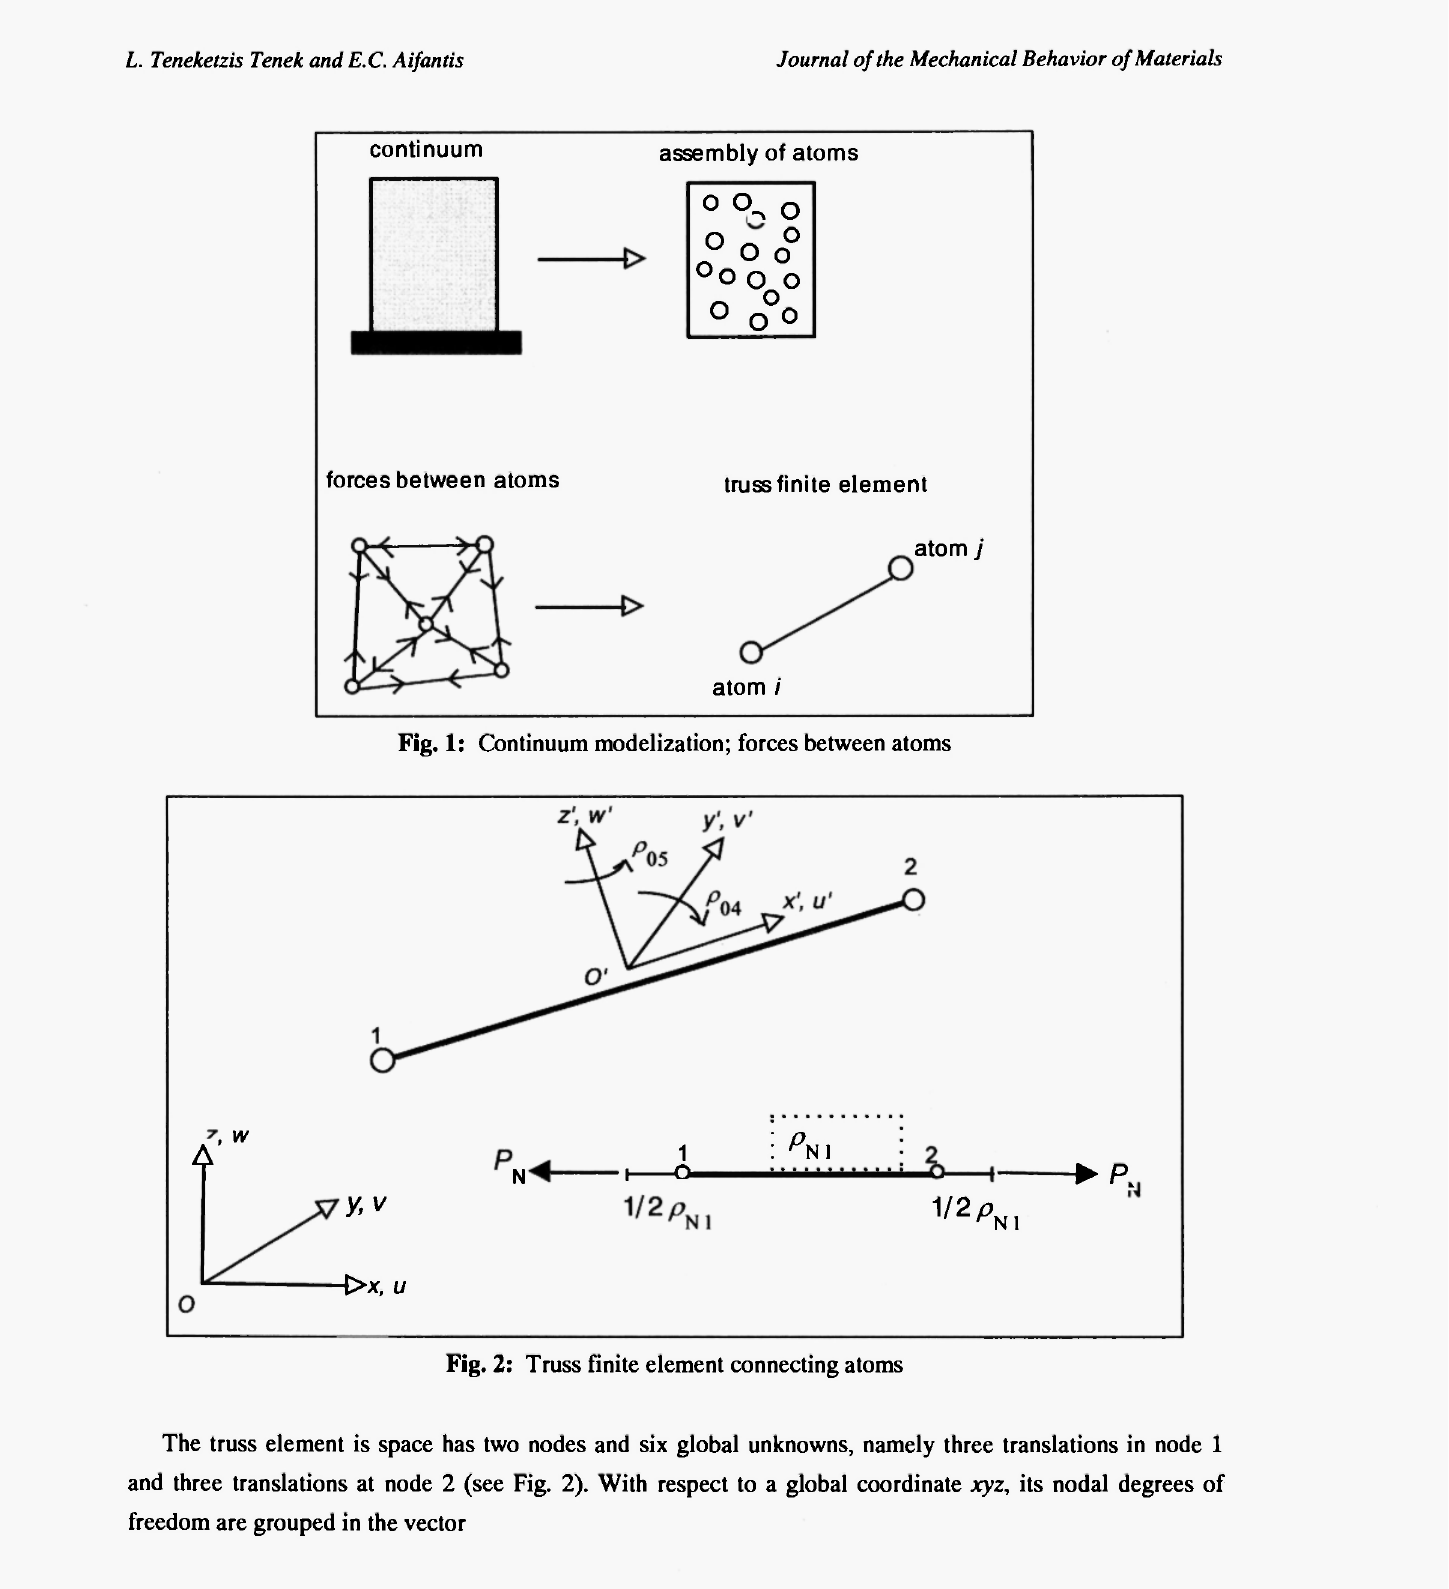
Fig. 2: Truss finite element connecting